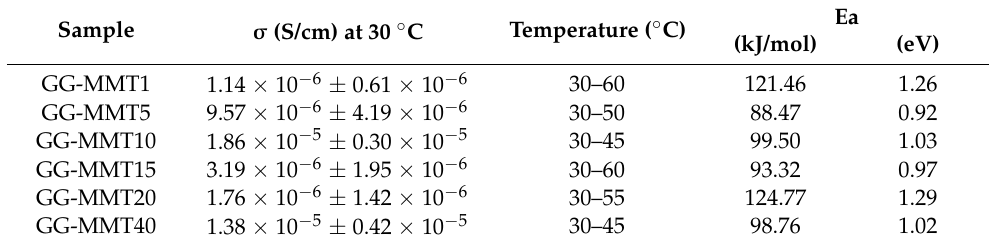
Table 3. Ionic conductivity and activation energy at 30 o C of GGLA NPEs.